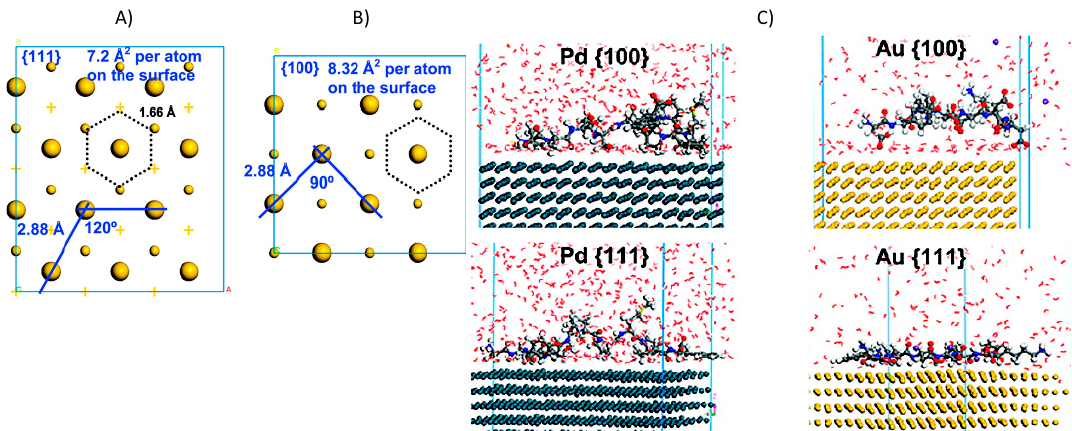
Figure 5. Comparison of the geometry (a) of the (111) surface and (b) of the (100) surface with numerical values for Au. Larger spheres represent the top atomic surface layer, smaller spheres represent the hcp sites and the crosses represent the fcc sites. Dotted black lines indicate energetically favorable orientations of aromatic rings such as in Tyr, Phe, and Trp. In (a), the ring or a sp2-hybridized group can occupy free fcc (111) “lattice” sites which contributes to high binding strength, while this is difficult to achieve in (100) lattice. Therefore, the small, flexible solvent molecules and possibly designed molecules with a rectangular repeat are of higher binding strength. (c) Representative snapshots of the Flg − Na 3 peptide on the pd and Au metal surfaces. Water interlayer is maintained between the peptide and the (100) surface, resulting in lower adsorption energy [85] .